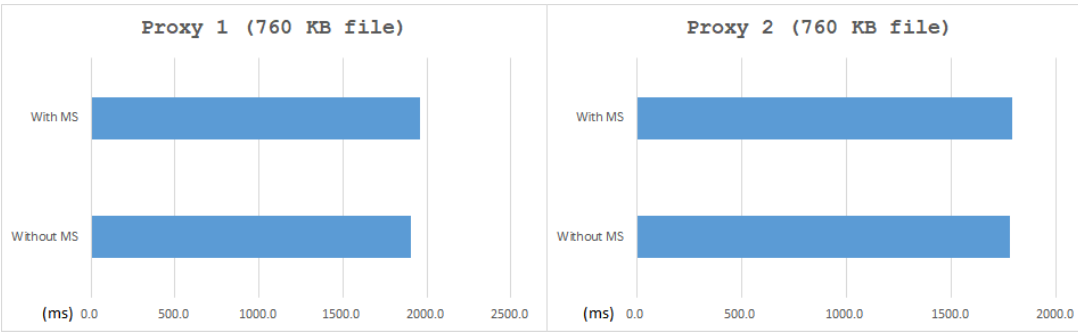
Figure 13. Average time of Proxy 1 and Proxy 2 when defending against DDoS attacks — downloading image.